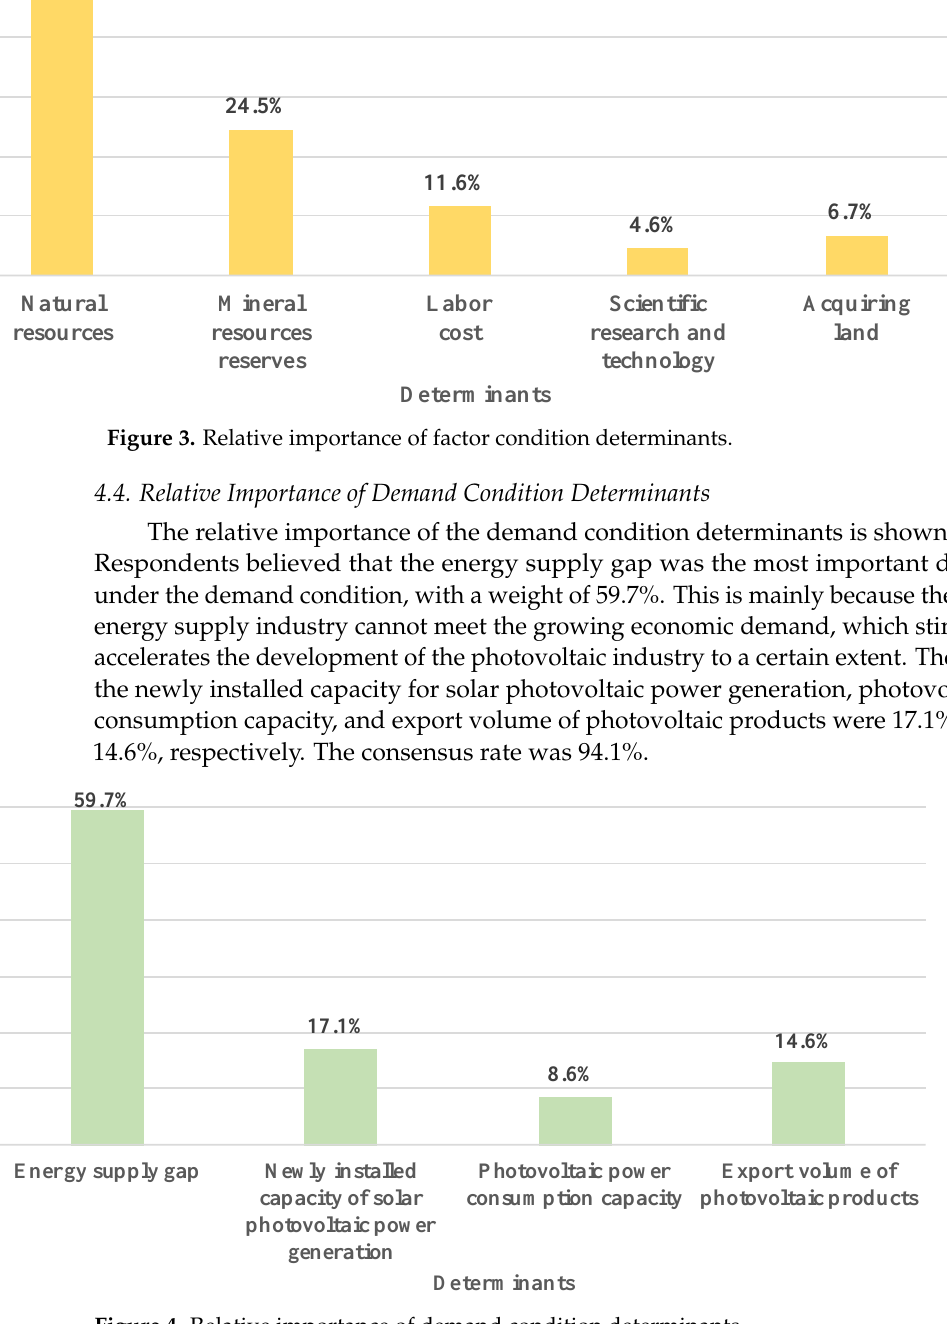
Figure 4. Relative importance of demand condition determinants.